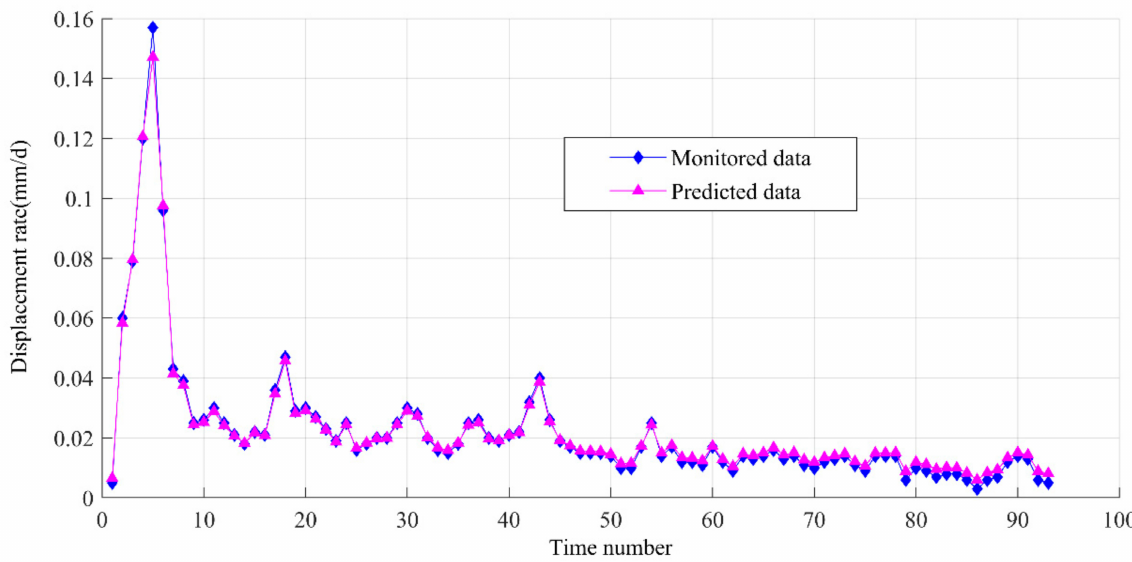
Figure 8. The monitored and predicted displacement rate of two-factor (displacement rate and reservoir water level) SVRM model over